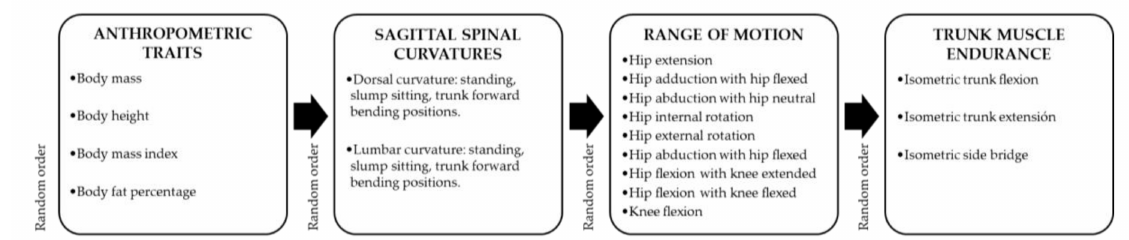
Figure 1. Assessment schedule of potential risk factors for lower back pain in the evaluation